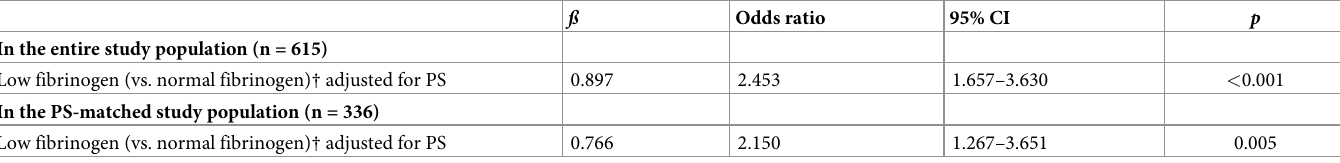
Table 3. Association between low fibrinogen level and postoperative AKI.